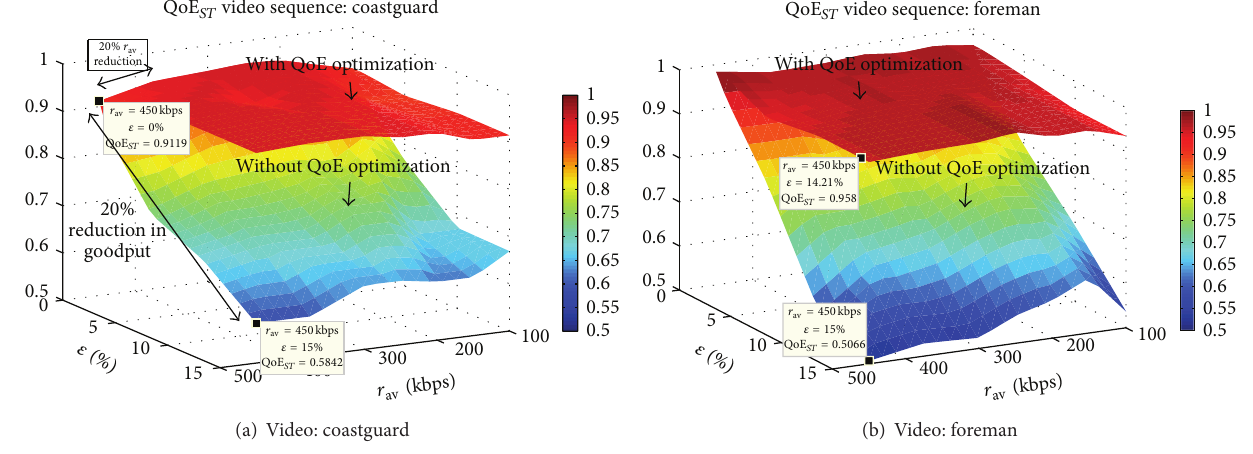
Figure 8: QoE optimization in the space domain. QoE 𝑆𝑇